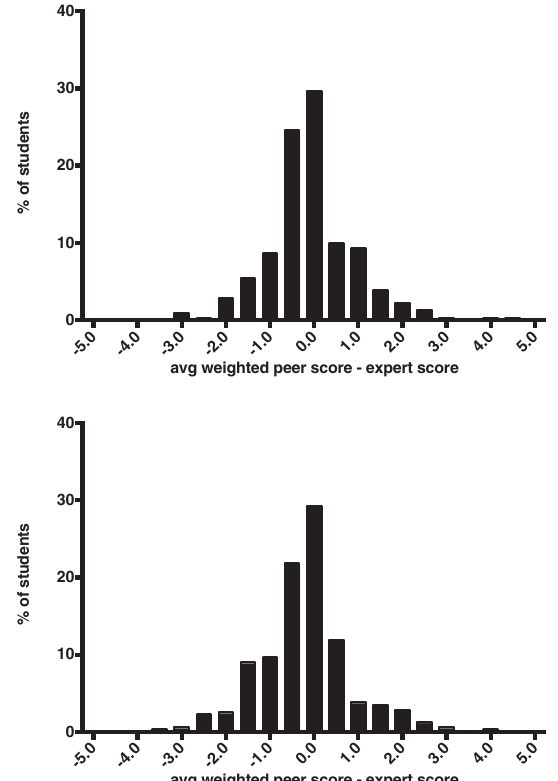
FIG. 4. Research scores plotted versus average weighted peer scores for the magnetism ( N ¼ 313 , upper) and Newton ’ s second law ( N ¼ 312 , lower) CPR tasks.